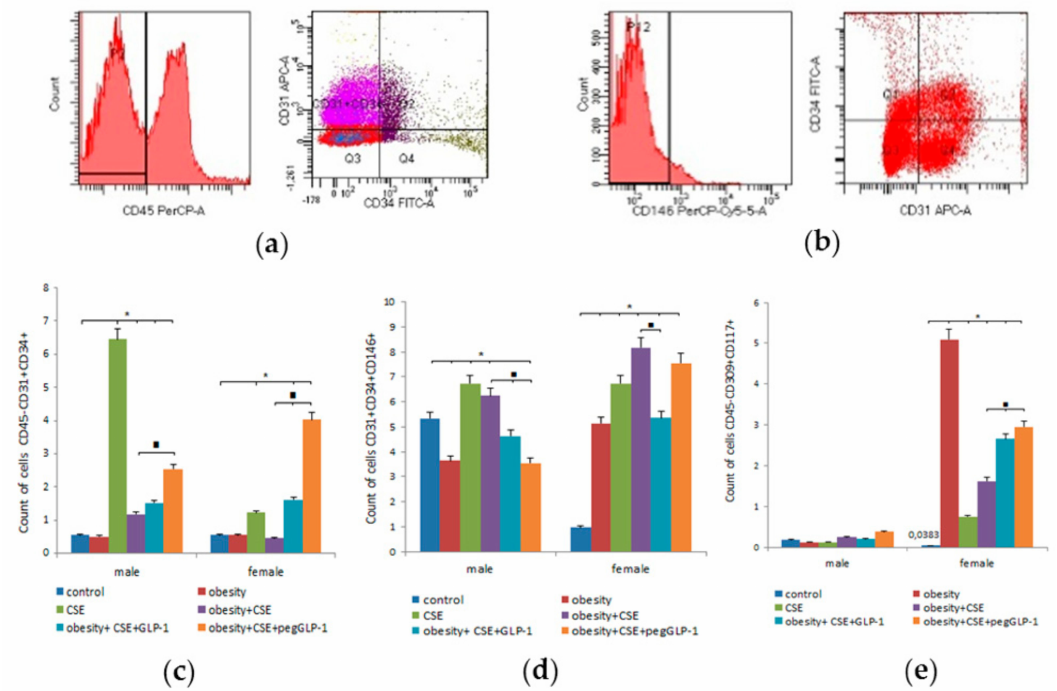
Figure 7. Characterization of cell population isolated from the bone marrow of male and female C57BL / 6 mice on the p189. ( a ) Phenotype establishment and qualitative analysis of CD45 (PerCP), CD34 (FITC), and CD31 (APC) expression; ( b ) Phenotype establishment and qualitative analysis of CD34 (FITC), CD31 (APC), and CD146 (PerCP-Cy5.5) expression; ( c ) The content of EPC (CD45 − CD31 + CD34 + ); ( d ) The content of EPC (CD31 + CD34 + CD146 + ); ( e ) The content of angiogenesis precursors (CD45 − CD309 + CD117 + ). Cells were analyzed by flow cytometry using antibodies for CD45, CD31, CD34, CD146, CD117, CD309 mice. Dot plots are representative of three independent experiments with the mean from three independent experiments. Groups: control—a control group from intact mice, obesity—mice with MD (obesity and hyperglycemia), CSE—mice with lungs emphysema, obesity + CSE—mice with MD (obesity and hyperglycemia) and lungs emphysema, obesity + CSE + GLP-1—mice with MD (obesity and hyperglycemia) and lungs emphysema treated with GLP-1, obesity + CSE + pegGLP-1—mice with MD (obesity and hyperglycemia) and lungs emphysema treated with pegGLP-1. *—significance of di ff erence compared with control ( p < 0.05); (cid:4) —significance of di ff erence compared with the obesity + CSE group ( p <